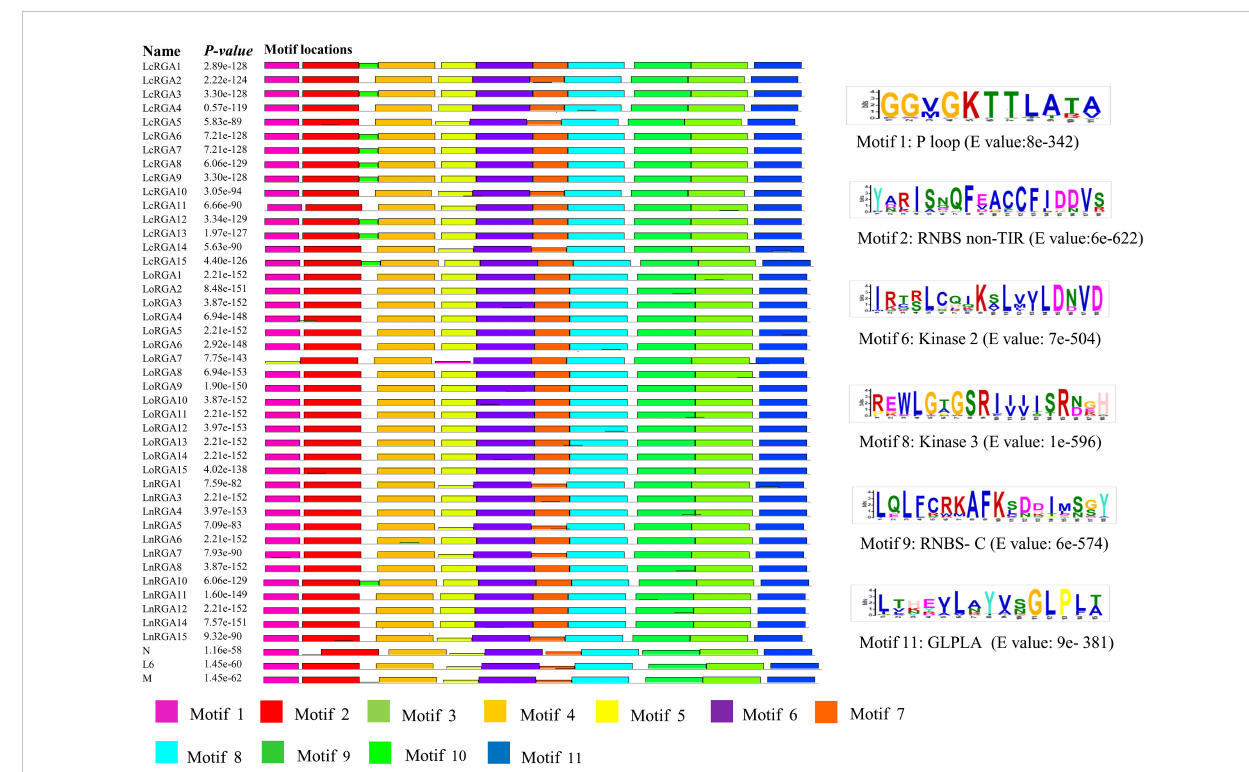
FIGURE 8 Diagrammatic representation of conserved motif of TIR RGAs within NBS domain along with R genes N, L6, and M. The solid black line represents each RGA, and their lengths with motifs are represented in colored boxes. The sequence logo of six conserved motifs along with their E value is presented on the right-hand